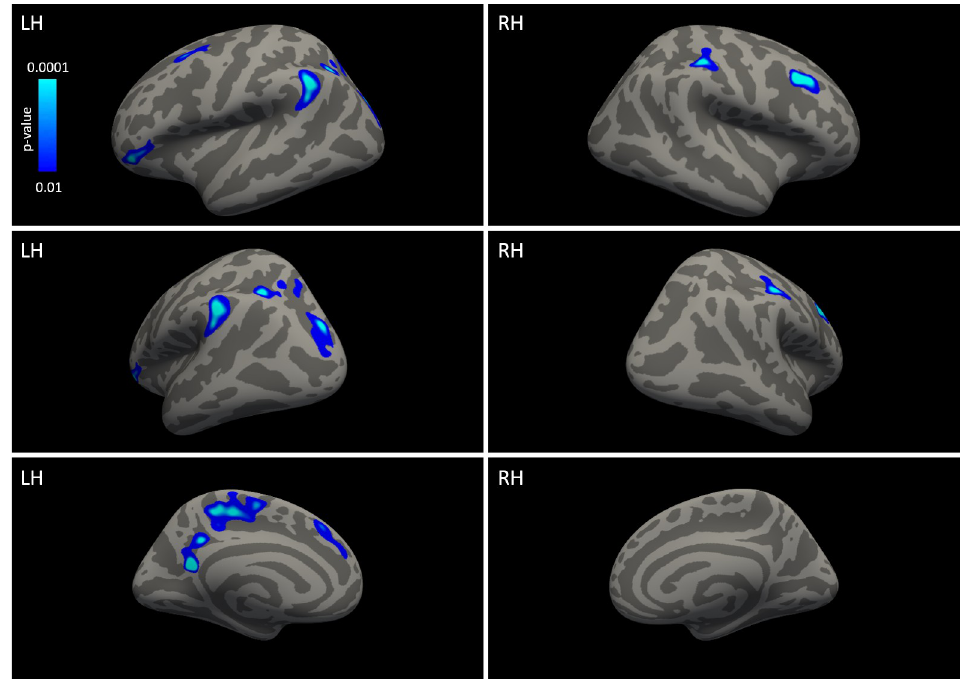
Fig 1. Inflated view of cortical thickness differences in Chinese chess